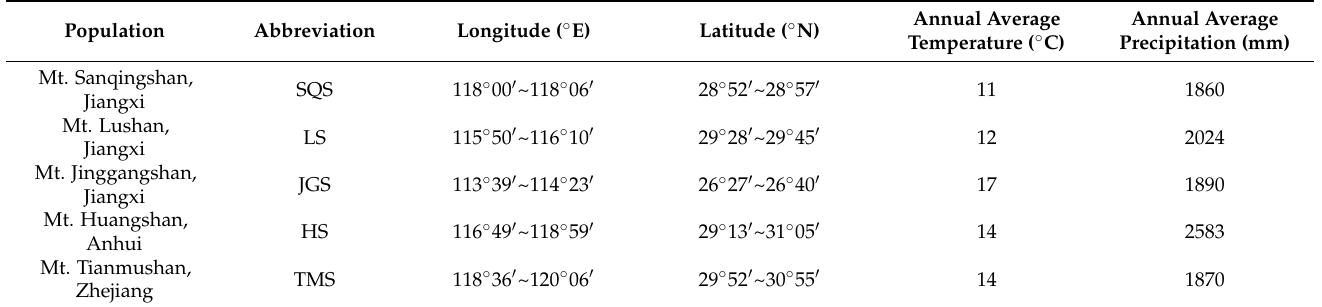
Table 1. The geographic locations and main meteorological factors of the sample populations